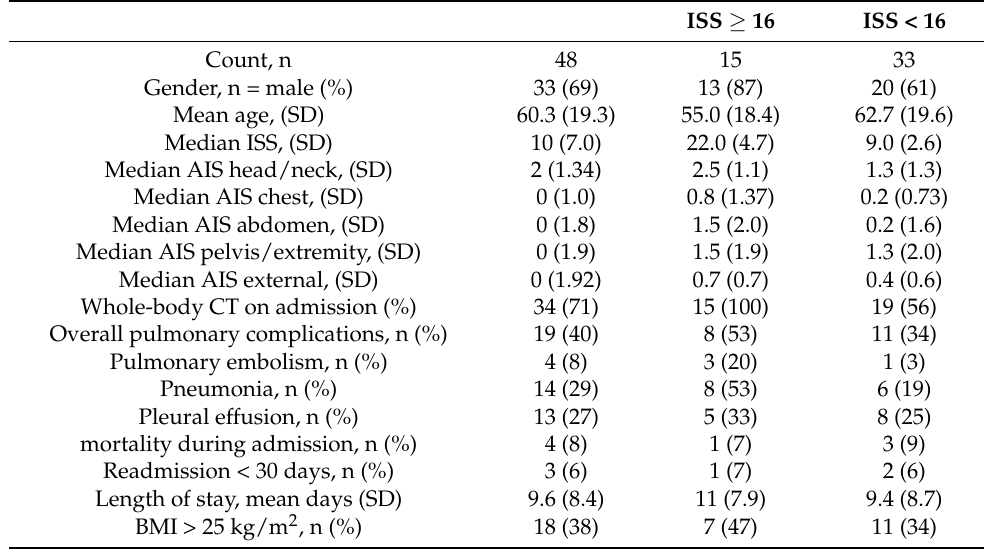
Table 1. Trauma patients with SARS-CoV-2